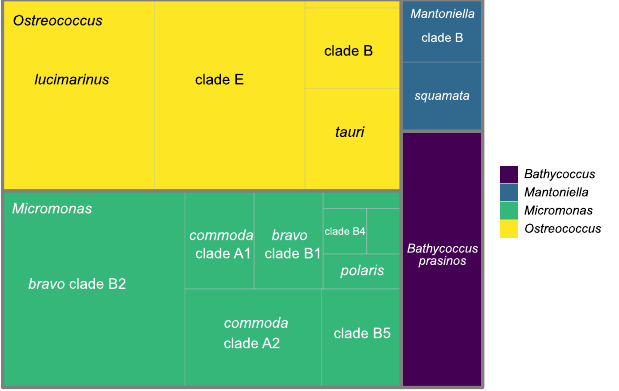
Figure 1. Treemap of the number of reads for Mamiellophyceae genera and clades for the OSD2014 LGC dataset. Only selected ASVs with more than 200 total reads (Table 1) and stations with more than 100 Mamiellophyceae reads (Table S1) were taken into